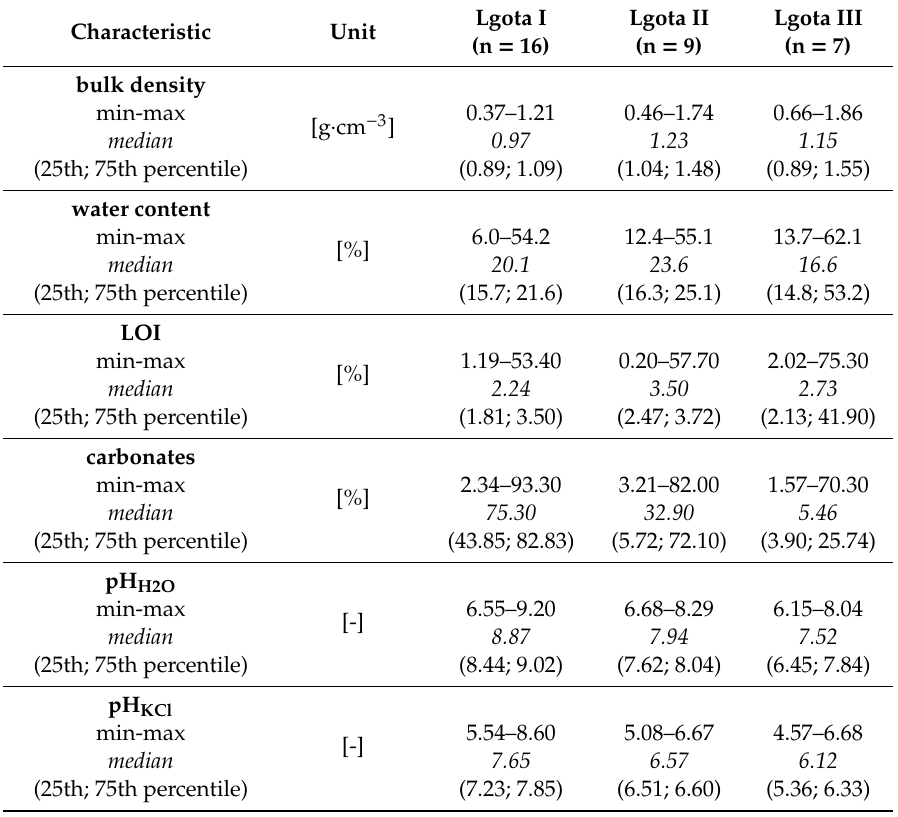
Table 1. The soil characteristics in the profiles from the Lgota